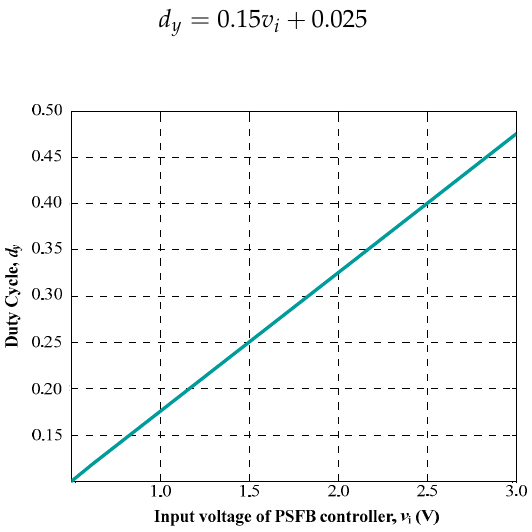
Figure 7. Relationship of operating duty cycle d y to input voltage v i.